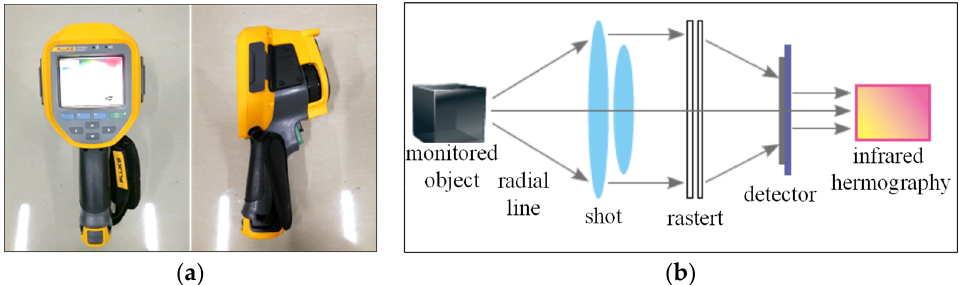
Figure 4. Infrared thermal imager and its working principle. ( a ) Infrared thermal imager; ( b ) and working principle.